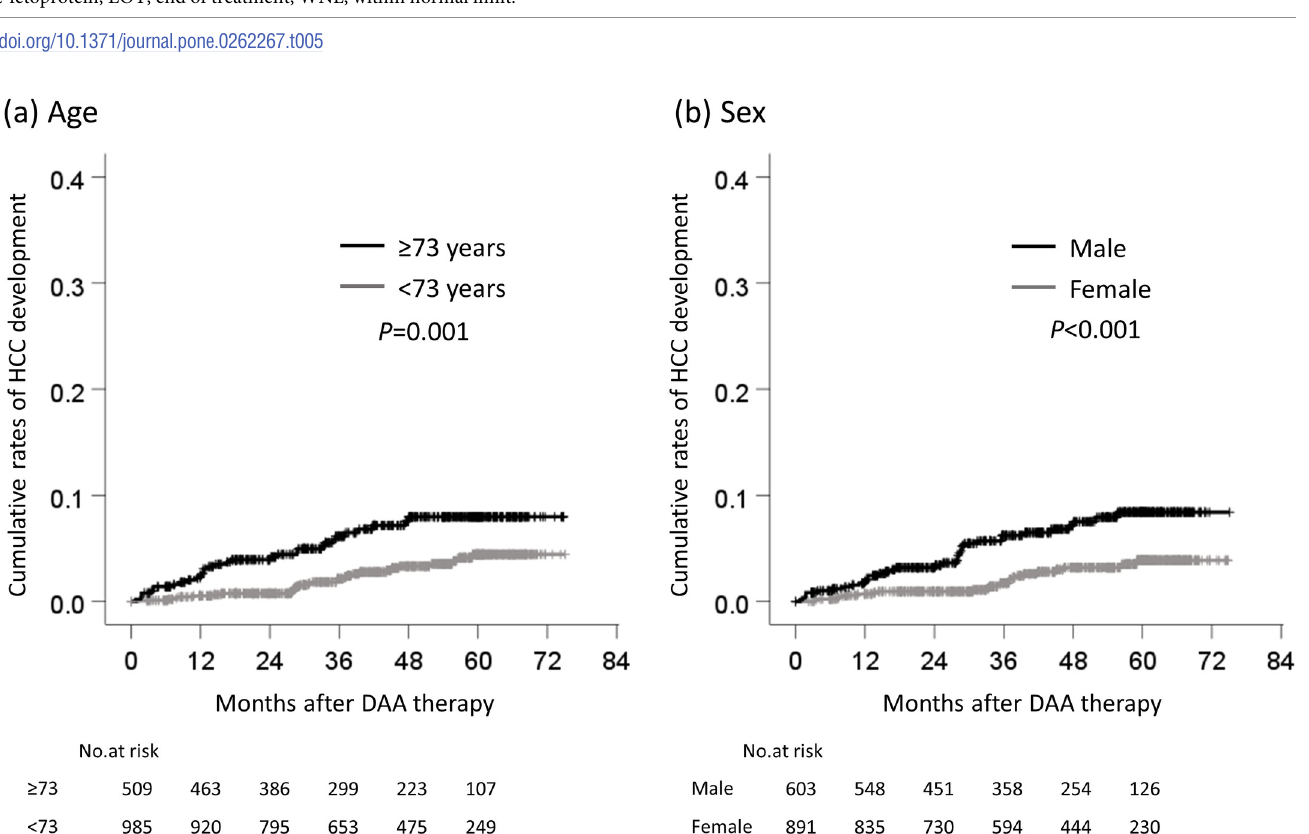
PLOS ONE | https://doi.org/10.1371/journal.pone.0262267 January 12,